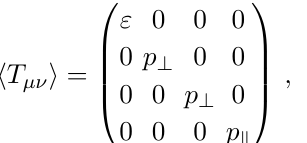
JHEP06(2019)128